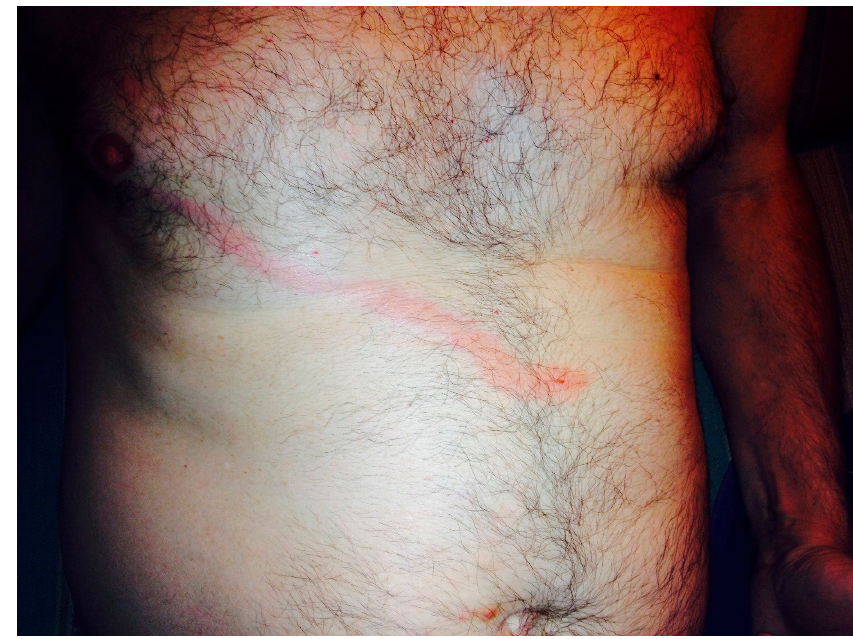
Figure 2. Similar lesion presented six years before.